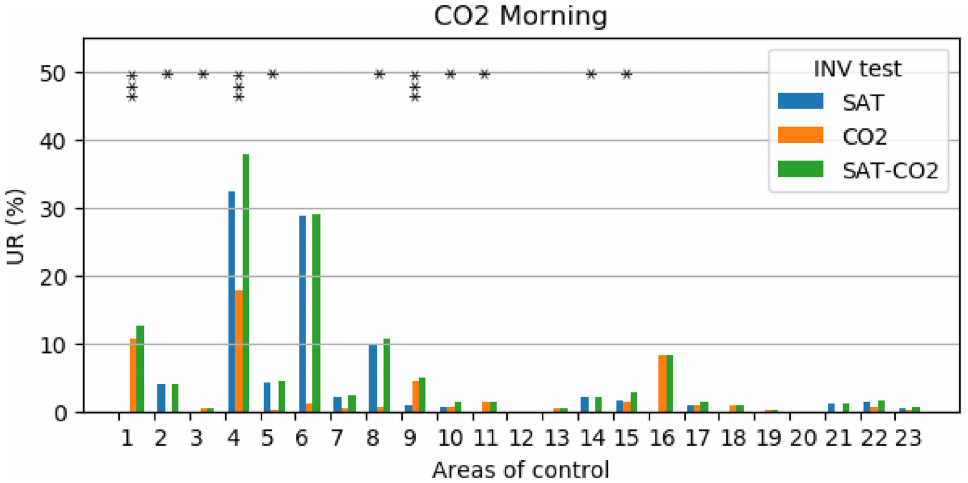
Figure A3. Uncertainty reduction in INV-SAT, INV-CO2, and INV-SAT-CO2 inversions for morning budgets of FF emissions of each controlled area in the main area of interest. The number of stars indicates the number of stations in each controlled area. The controlled areas are listed in Table 1.